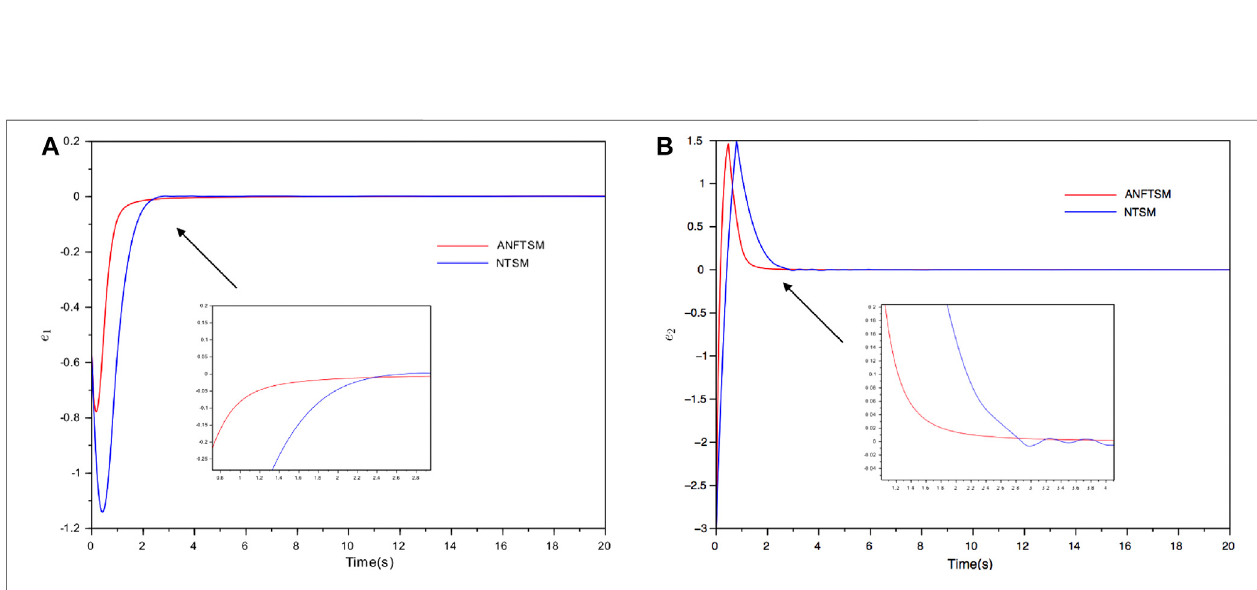
FIGURE 9 | The comparison of synchronization errors between the ANFTSM and NTSM in Example 2 (A) the synchronization error e 1 (B) the synchronization error e 2